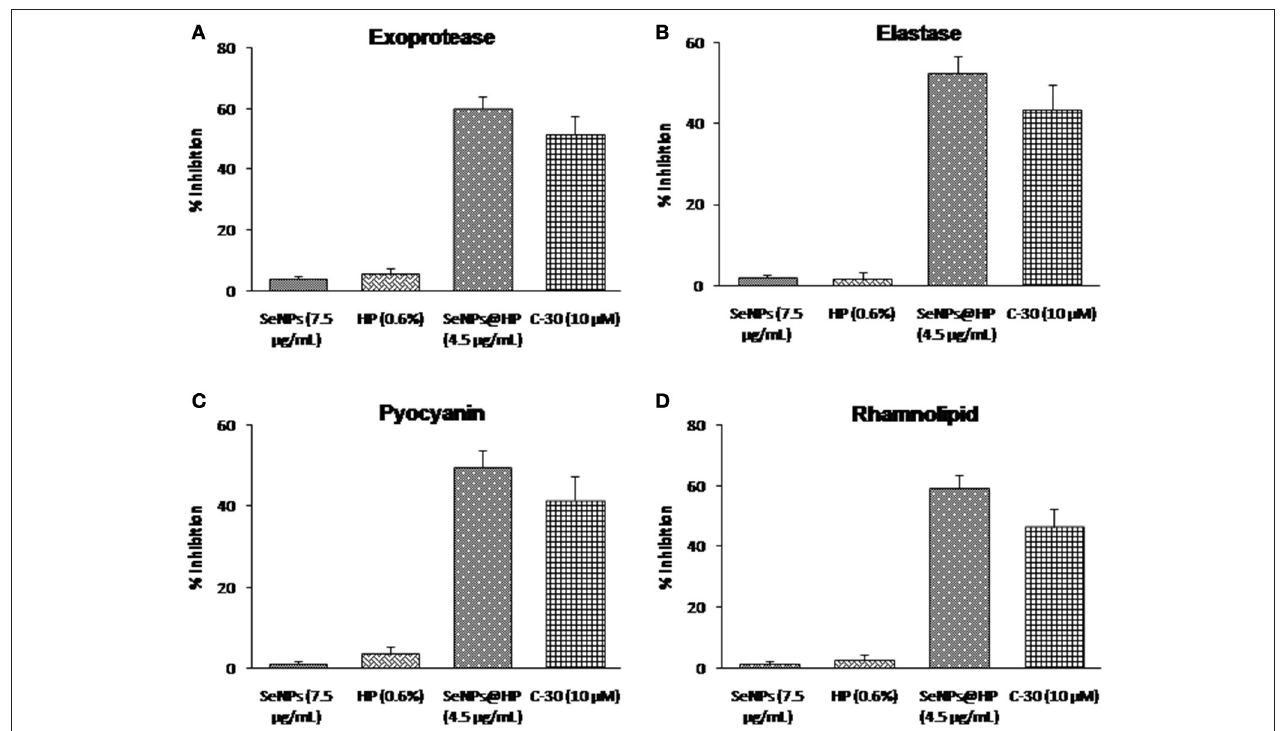
FIGURE 5 | Impact of SeNPs@HP on the secretion of virulence factors. Levels of virulence factors such as (A) exoprotease, (B) elastase, (C) pyocyanin, and (D) rhamnolipid were measured in SeNPs (7.5 µ g/mL), HP (0.6%), SeNPs@HP (4.5 µ g/mL), and furanone C-30 (10 µ M) treated or untreated culture filtrates of P. aeruginosa PAO1. Error bars indicate the standard deviations of 8 measurements.